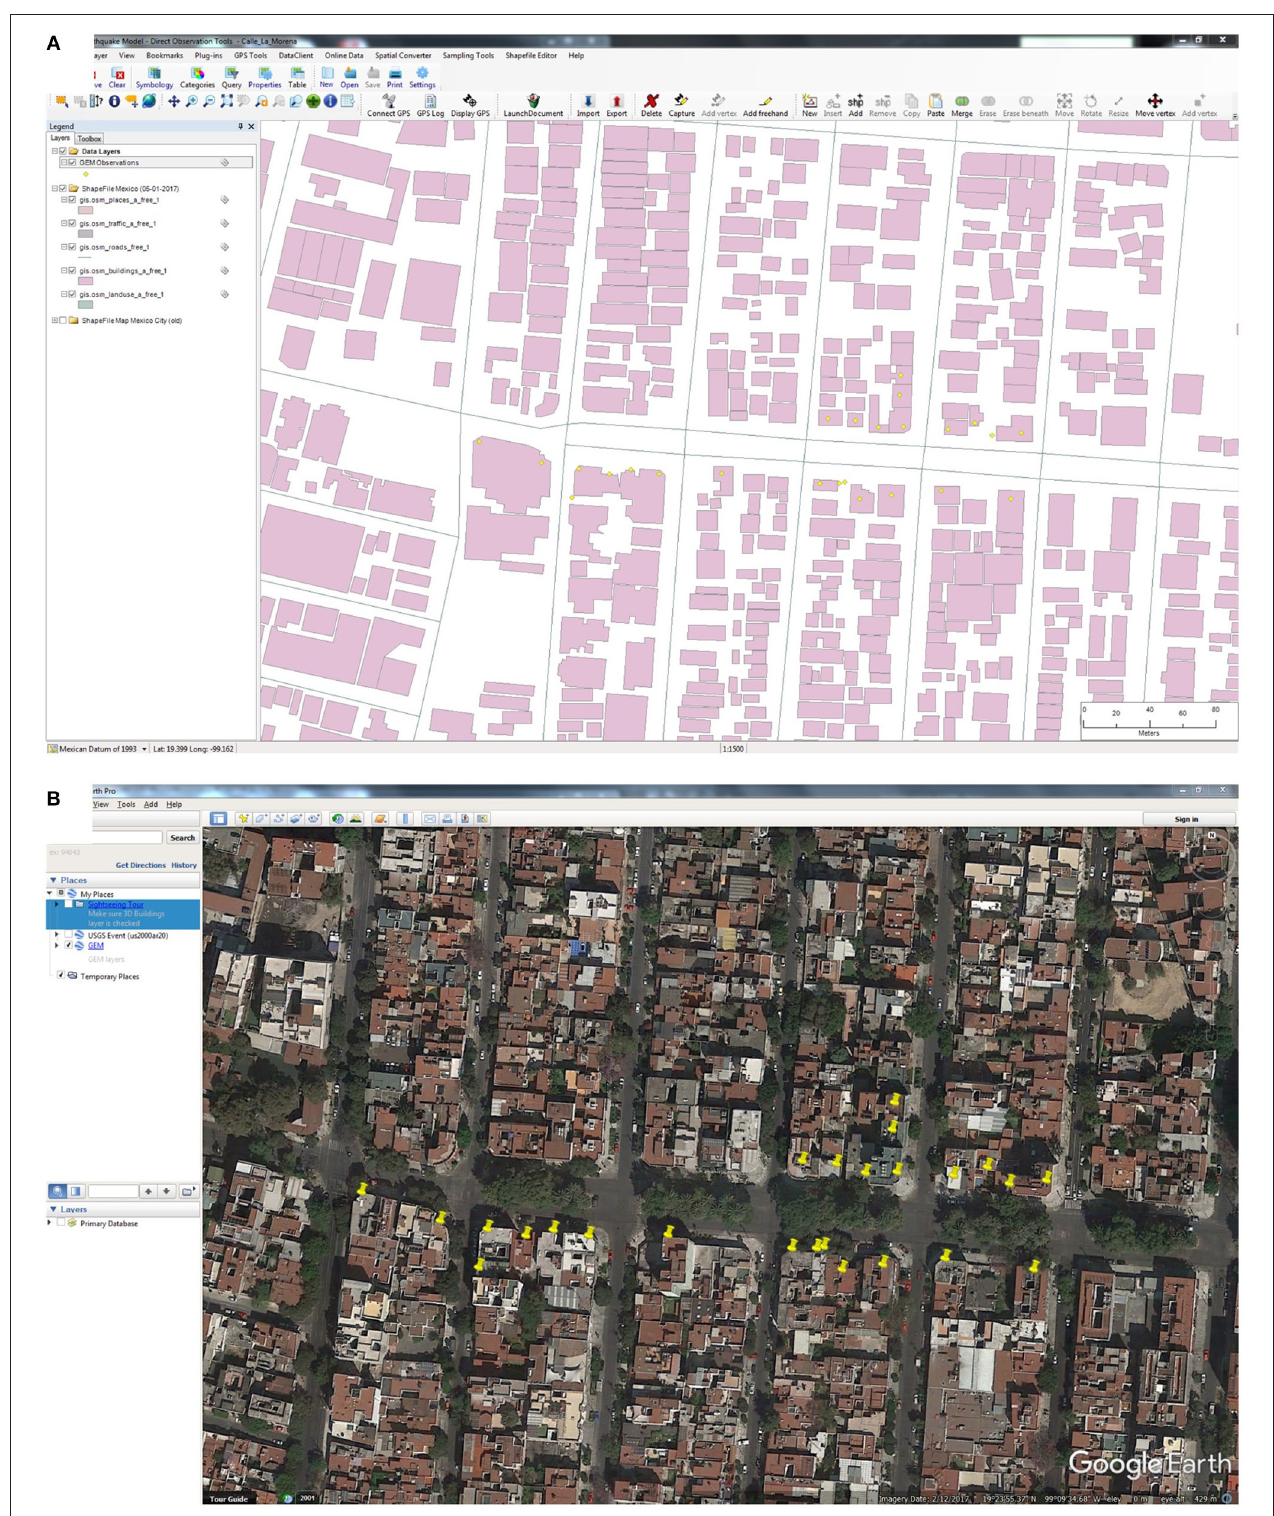
FIGURE 4 | Screenshots of the GEM IDCT software. (A) Depicting building boundaries property as available from shape files. (B) Post earthquake assessment exported as kmz file overlayed over satellite images in Google Earth.